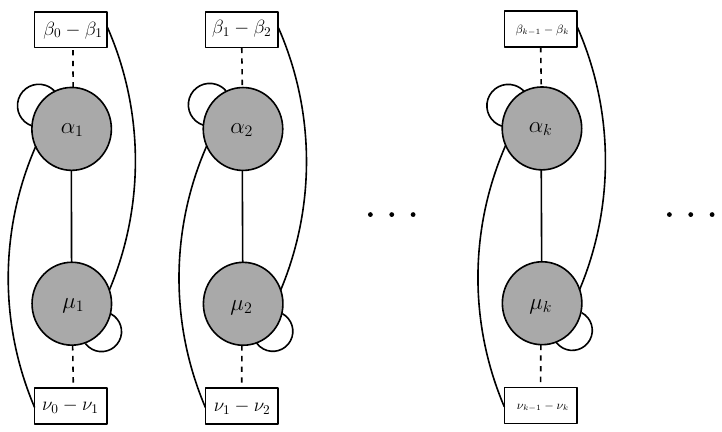
Figure 10 . Disconnected quivers describing the SCQMs dual to our